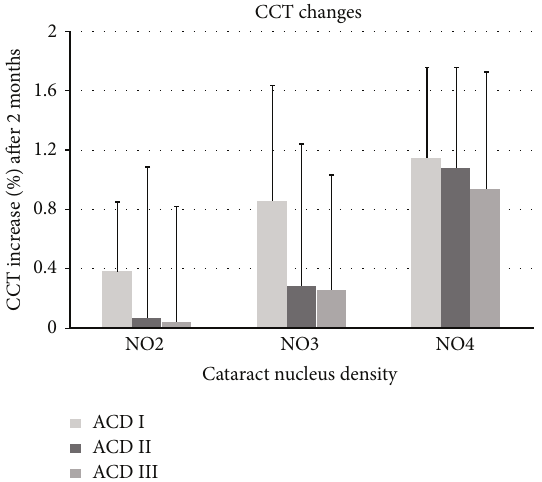
Figure 1: Postoperative changes of CCT by cataract nucleus density and ACD groups (no statistical significance in Bonferroni and Dunnett’s T3 as post hoc analysis).